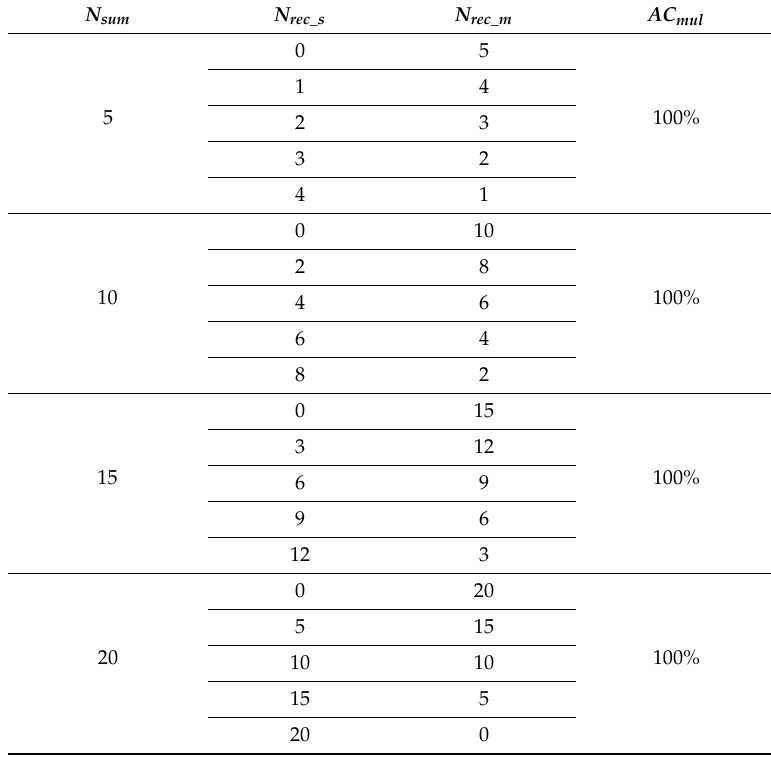
Table 3. Accuracy result with multiple